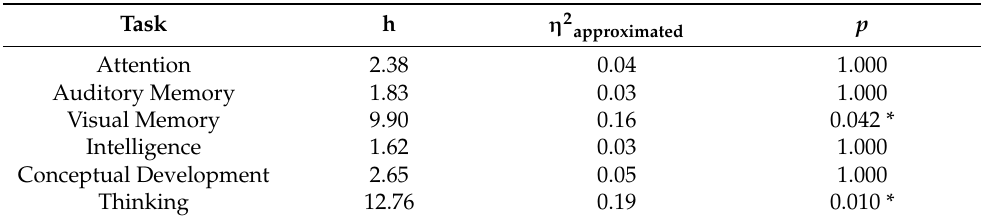
Table 1. Results of Kruskal–Wallis H-test series testing the hypothesis that population median performances in different cognitive tasks are equal between AMC patients, OBPP patients, and control children. p -values are adjusted by means of Bonferroni correction (included eta-squared values for the Kruskall–Wallis series with H-values following Murphy and Myors ([20], Appendix A), ‘*’—statistically significant values).